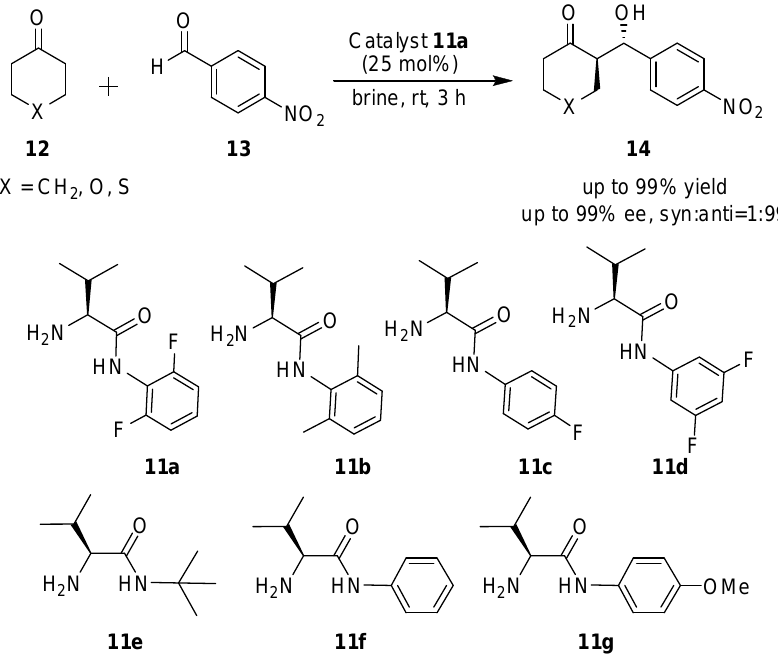
Scheme 9. Asymmetric aldol reaction using simple amino amides as chiral agents.